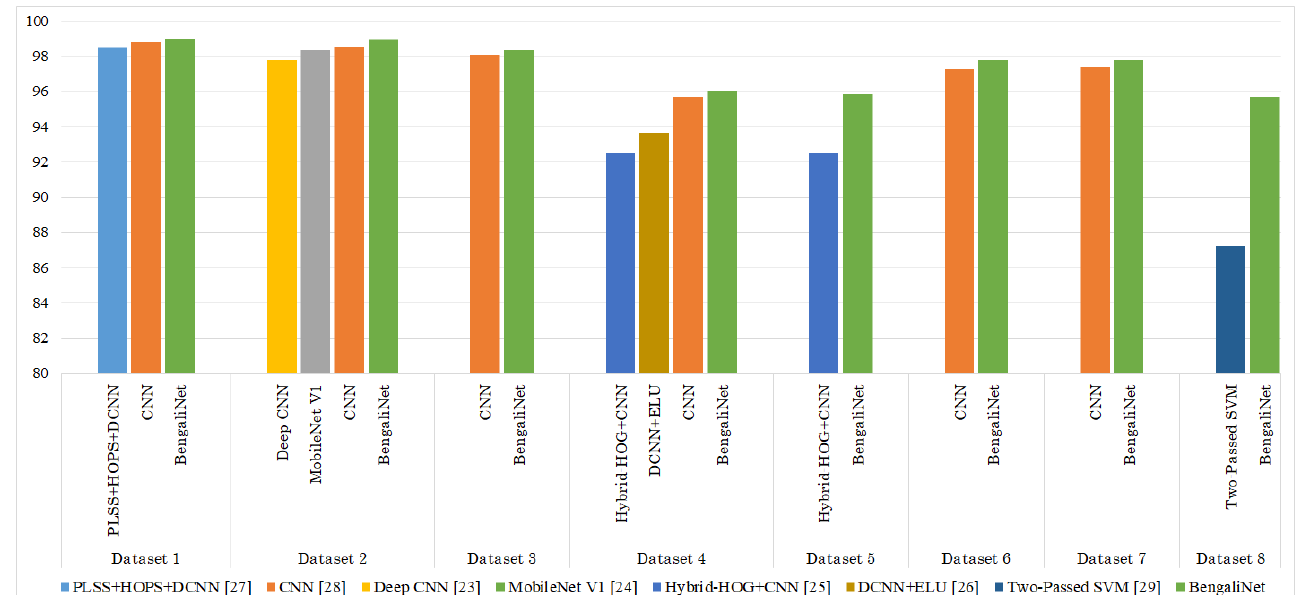
Figure 10. Illustration of performance comparison for all 8 datasets among previous noteworthy approaches and our proposed architecture in terms of overall accuracy.